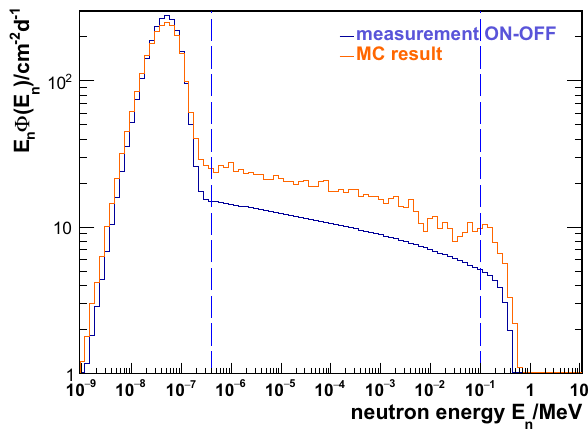
Fig. 18 Neutron energy distributions of the residual fluence ( E ) , calculated via Eq. (8) from the experimental BSS data anal- Φ (res) n mean ysis, and the calculated fluence Φ MC ( E n ) based on MC simulations. The distribution Φ MC ( E n ) was scaled to match the integral fluence of Φ (res) mean in the thermal neutron region. The vertical dotted lines indicate the limits of the individual E n regions, as defined in Table